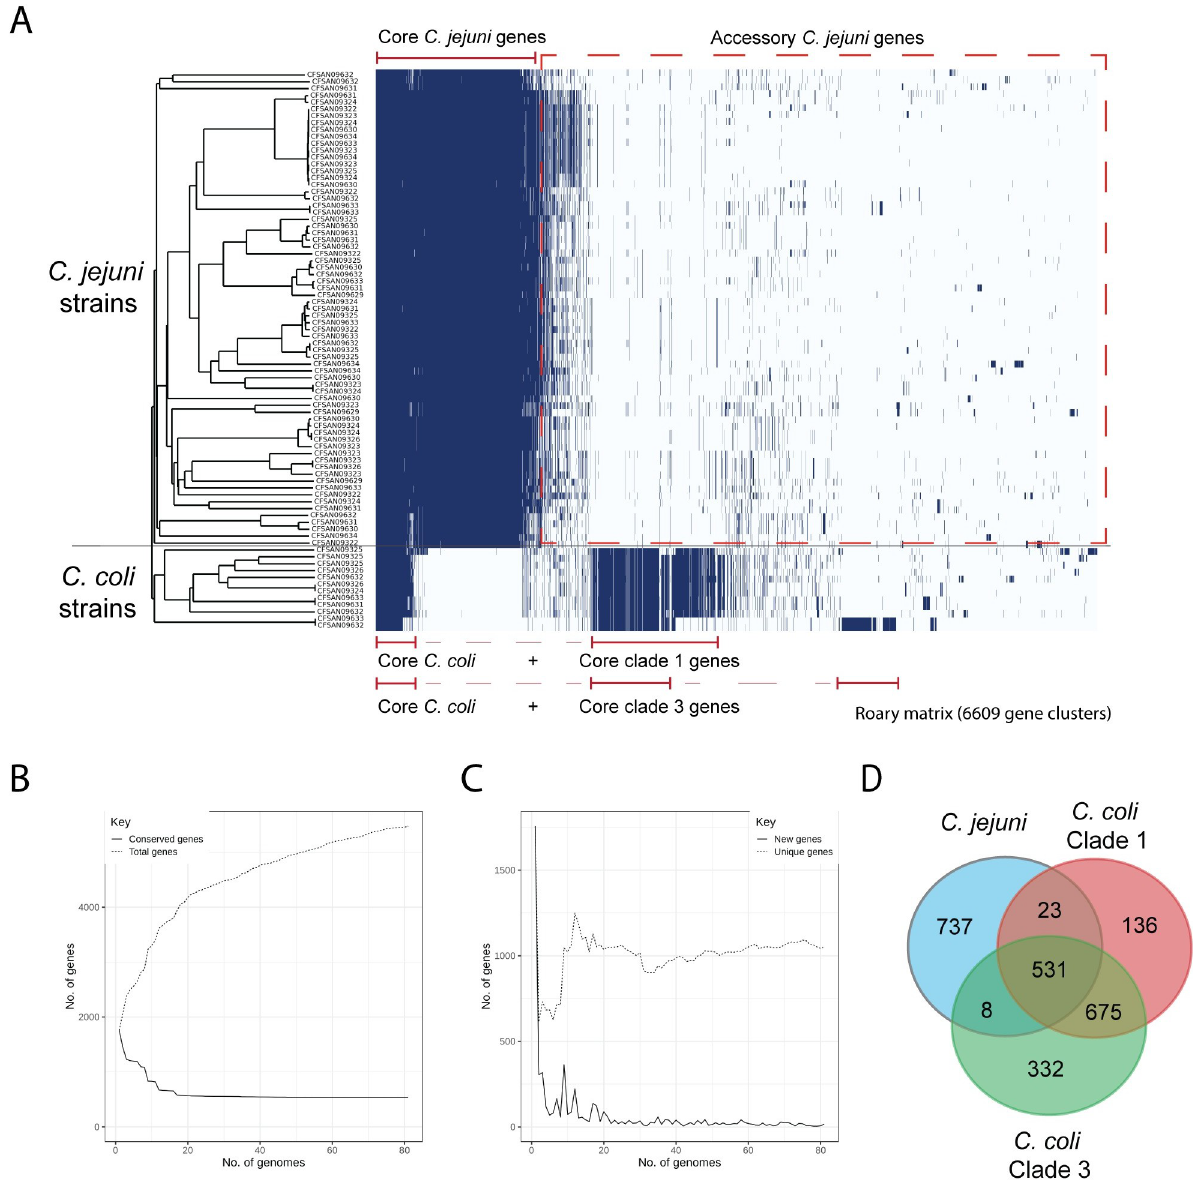
Fig 3. Visualization of the pangenome of the C . jejuni and C . coli strains. Pangenome analysis was performed using Roary. Core and accessory genomes are highlighted with red and black brackets, respectively. cgMLST phylogenetic tree of Fig 1A is shown on the left. B) The graph shows the number of genes in the core and pan genomes (continuous and discontinuous lines respectively) as increasing number of genomes are considered in random order. C) The number of genes unique to a genome (discontinuous line) and new genes not found in previously analyzed strains (continuous line) as increasing number of genomes are considered in random order. D) A Venn diagram highlighting the number of core genes present in C . jejuni and C . coli strains from clades 1 and 3 is shown on the